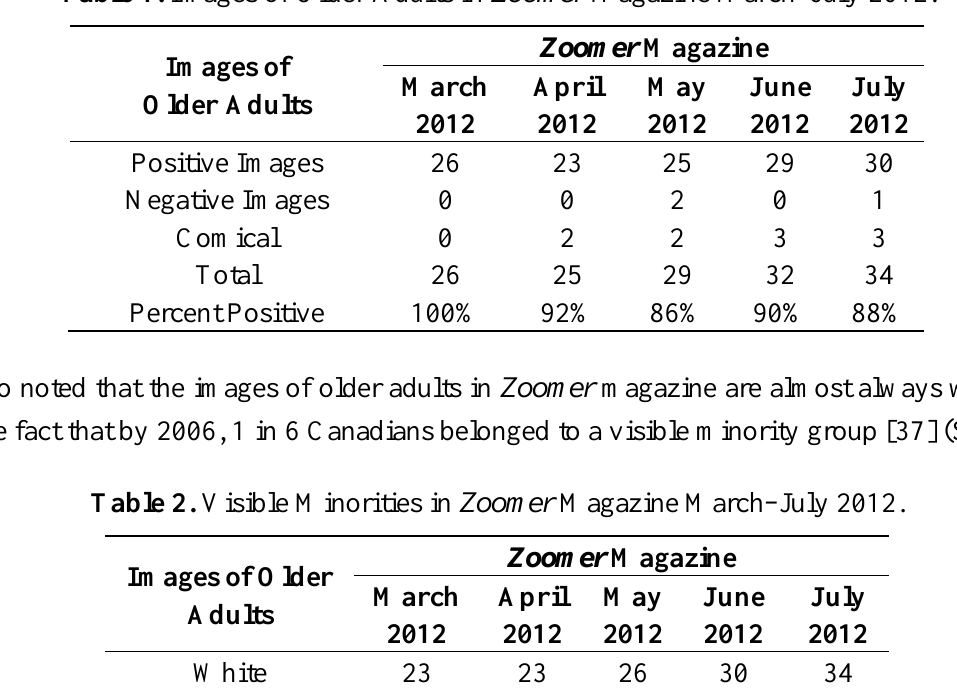
Table 1. Images of Older Adults in Zoomer Magazine March–July 2012.